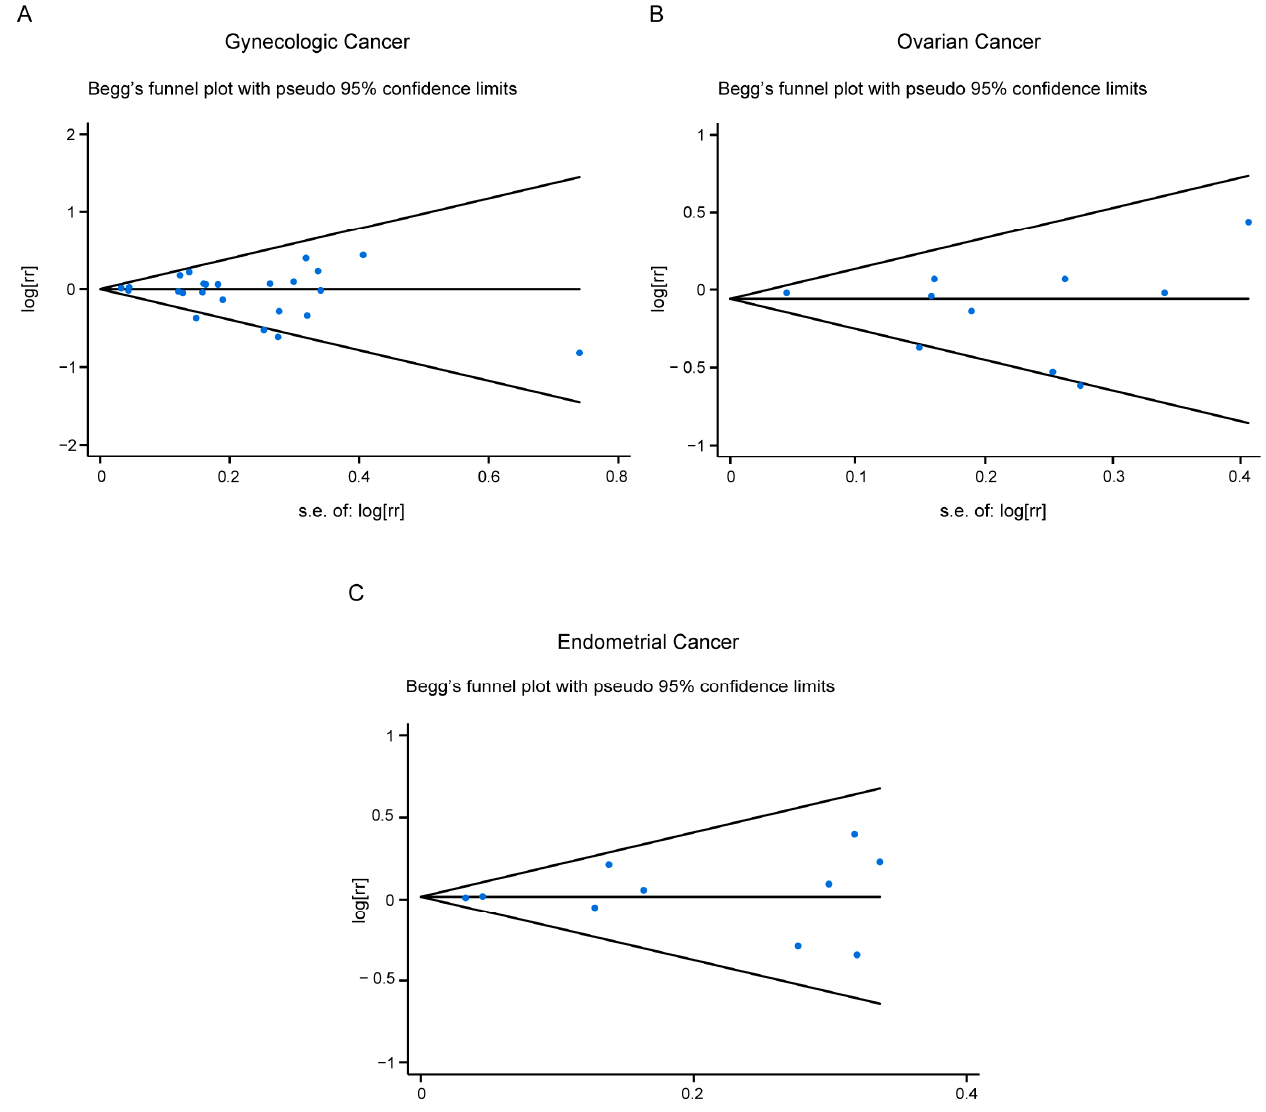
Figure 4. Publication bias for all studies included ( A ), or studies related with ovarian cancer risk ( B ), or endometrial cancer risk ( C ).